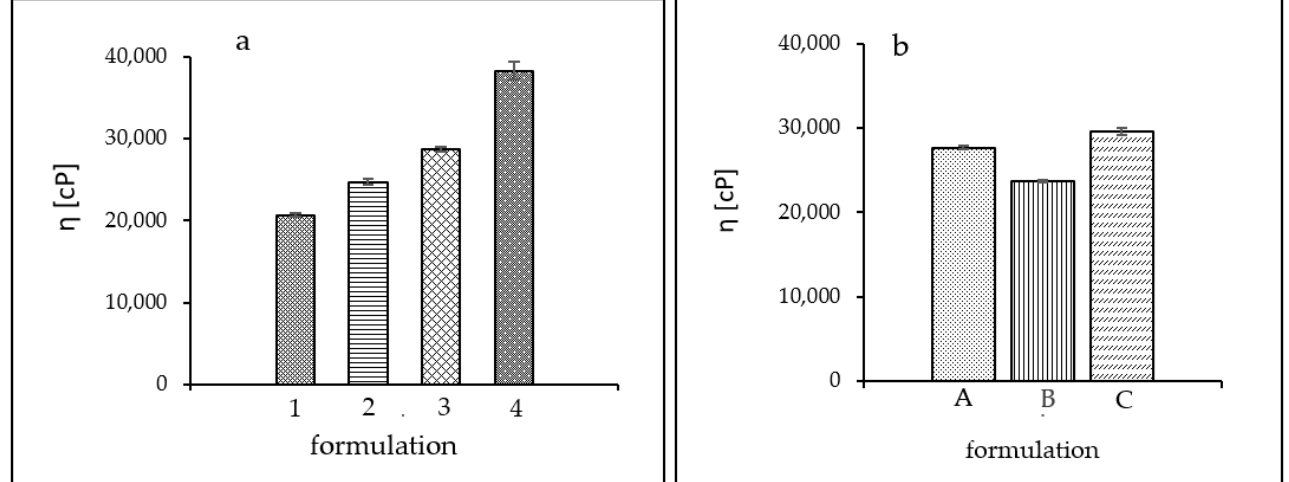
Figure 6. Viscosity values obtained. ( a ) Formulations ( 1–4 ) and ( b ) Formulations ( A–C ).